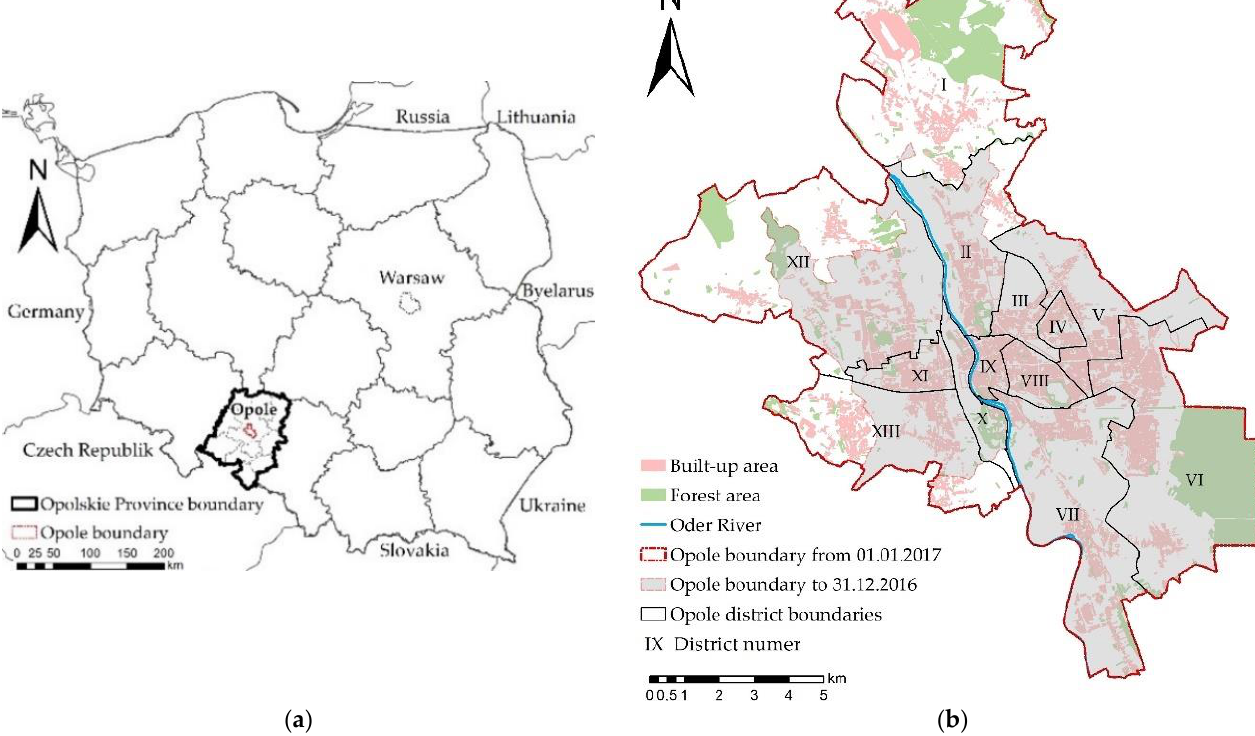
Figure 1. Location of the study area, Poland, Central Europe: ( a ) map of Poland with study area ( b ) city of Opole.